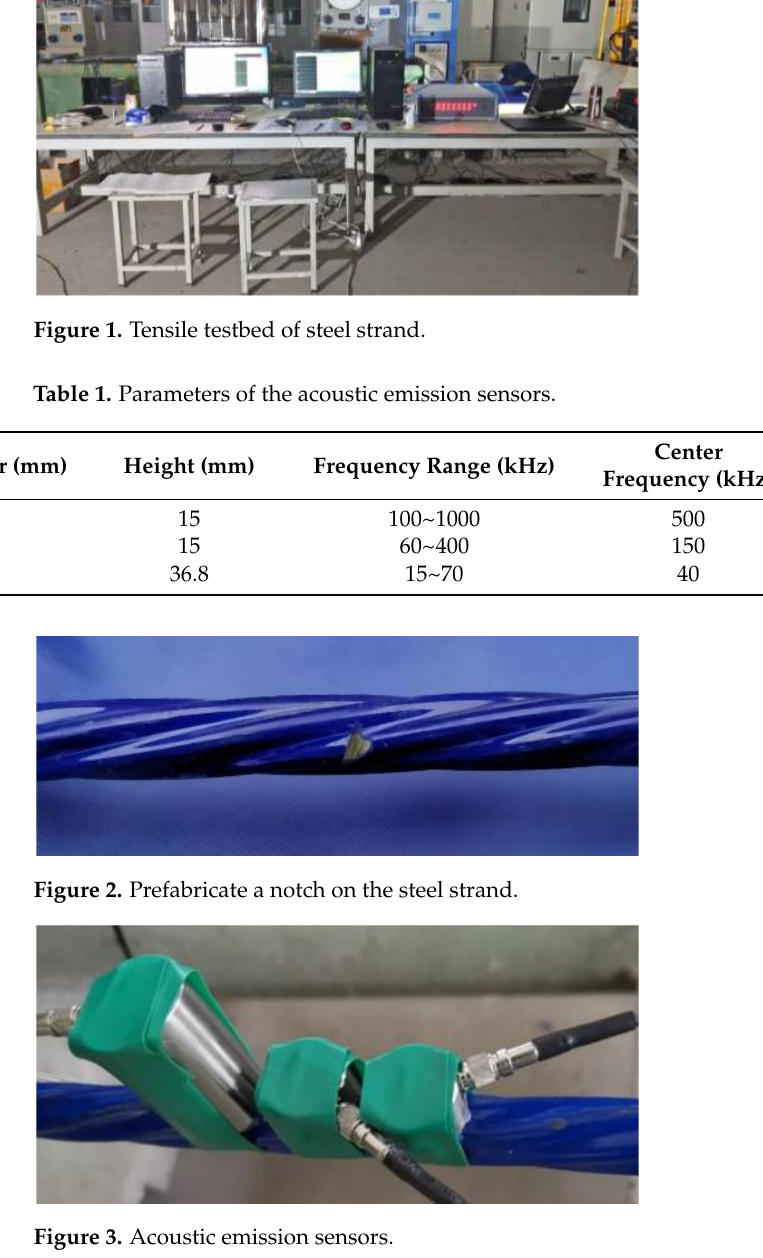
Table 1. Parameters of the acoustic emission sensors.